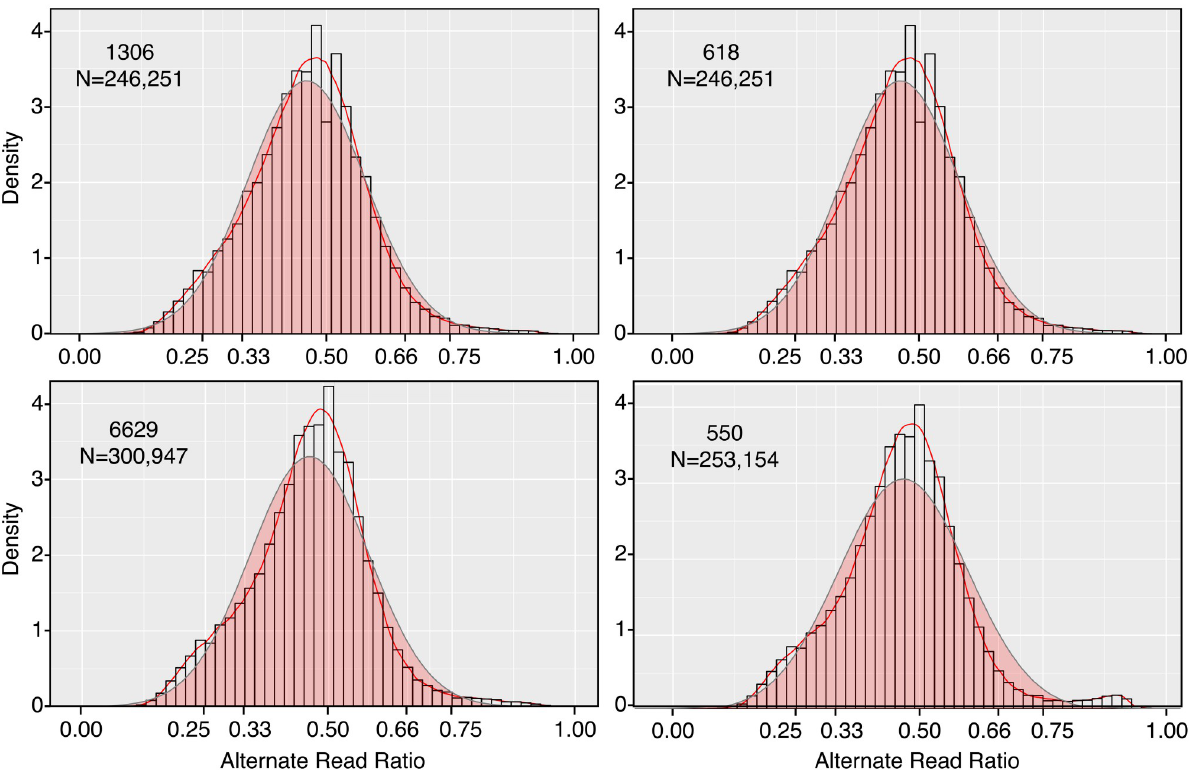
Fig 1. Alternate read ratios in parents of crosses. Heterozygous SNPs were identified in strains 1306, 618, 6629, and 550 by mapping Illumina reads to the Stitch7 assembly. Sequence variants (alternate reads) were identified and their ratio distributions modeled as described in Methods, with the y - axis referring to kernel density which is plotted as a red line. Also in the plot is a normalized distribution of the data (red fill, grey line), and the relative frequency of variants per bin (histograms). The number of SNPs scored for the strains are indicated in the panels.